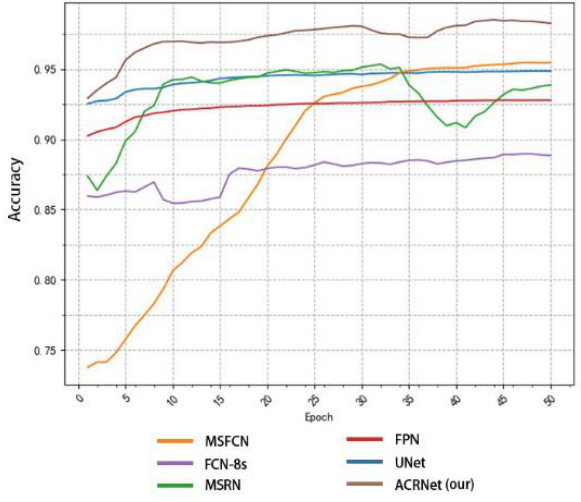
Figure 8. Variation of the accuracy of each model with the number of training epoch.